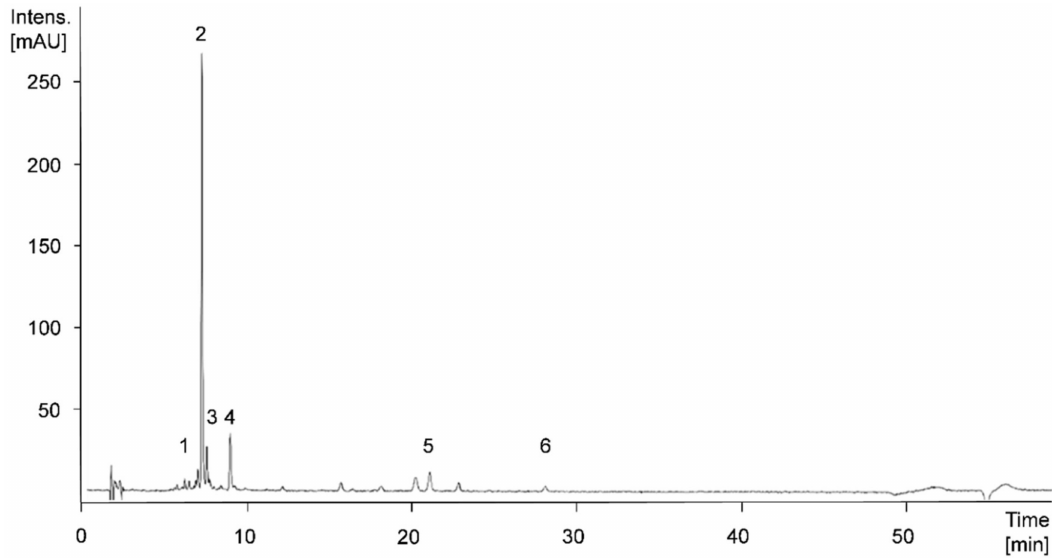
Figure 6. High Performance Liquid Chromatography Mass Spectrometry (HPLC-MS) n -chromatogram at 280 nm of apple cultivar ‘Jonagold’, biofortified with 0.075 kg Se / ha in the form of selenate in 2018. Peak numbers: 1, procyanidin dimer; 2, chlorogenic acid; 3, epicatechin; 4, procyanidin trimer; 5, phloretin-2-xylosyl-glucoside; 6,